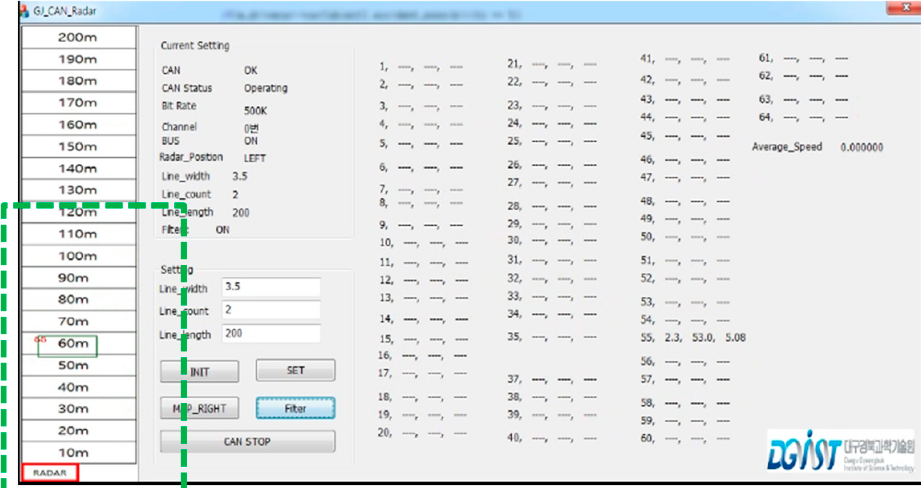
Figure 15. Target detection with noise filtering.